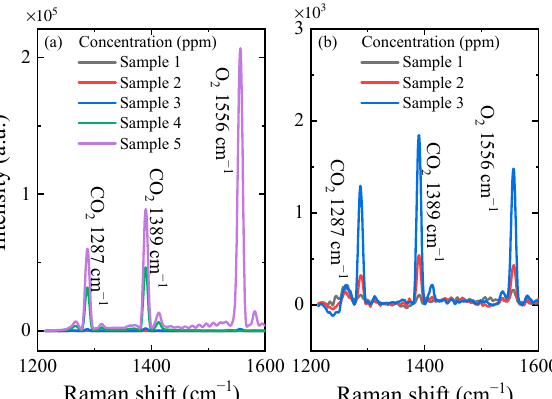
Figure 4. ( a ) The Raman spectra of sample 1 to sample 5. ( b ) The Raman spectra of sample 1 to sample 3. Table 1. The components of samples.